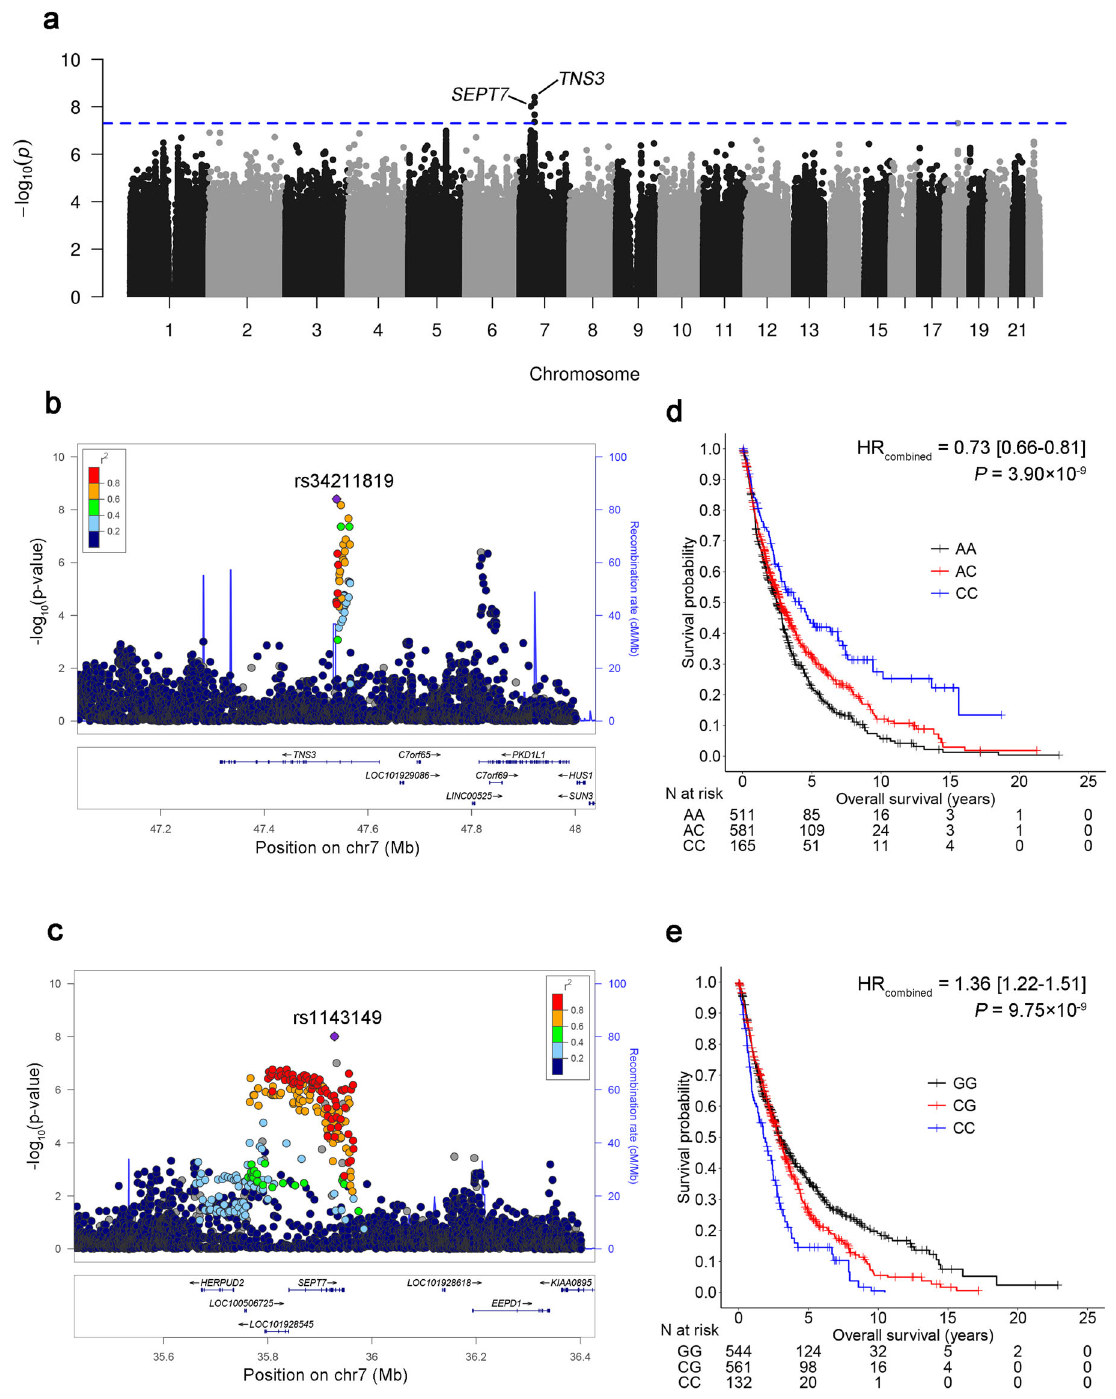
Fig. 1 Results of GWAS survival analysis. a Manhattan plot for survival analysis P values. All genetic variants were coded using an additive model. SNPs with a minor allele frequency >5%, imputation R 2 > 0.8, and Hardy – Weinberg equilibrium P > 1×10 − 5 were included. b , c Regional association plots for rs34211819 in TNS3 and rs1143149 in SEPT7 . The left-hand Y-axis shows − log10 transformation of the P -value of individual SNPs plotted against the chromosomal base-pair position with an expansion of 500 kb in the fl anks of the SNP position. The right-hand Y -axis shows recombination rate estimated for European populations from HapMap Data Rel 22/phase II. d , e Kaplan – Meier survival curves for rs34211819 and rs1143149 in NSCLC patients by 0, 1, and 2 minor alleles. HRs, 95% CI and P values were derived from Cox proportional hazards regression models adjusted for